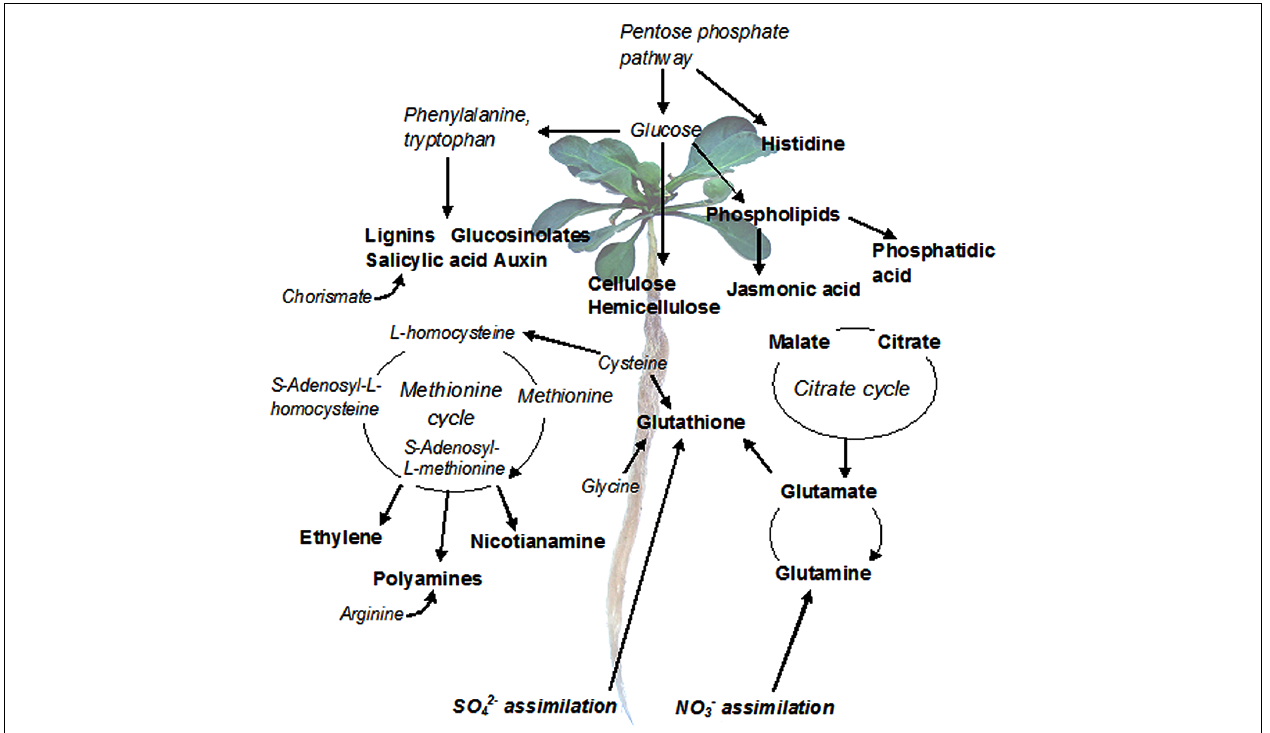
length for orthologous genes in A. thaliana and N. caerulescens , and the most highly expressed genes (expression value > 1000) were subjected to a more detailed analysis. The genes were manually linked to metabolic pathways in KEGG (Kyoto Encyclopedia of Genes and